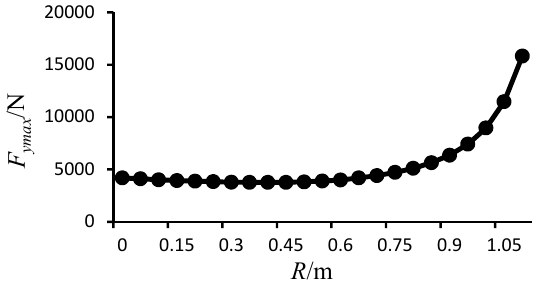
Figure 9. Maximum vertical impact force through varying tip radius.